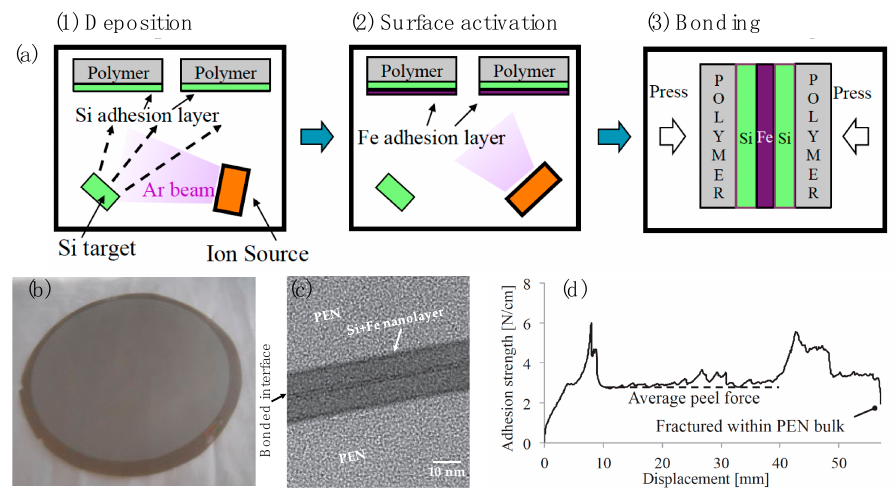
Figure 5. ( a ) Schematic diagram for surface-activated nanoadhesion layers-based bonding of thin polymers; ( b ) Optical image of the void-free interface of 100 mm in diameter PEN/PEN films; ( c ) High-resolution transmission electron microscope image of the bonded interface of PEN/PEN, showing a 20-nm-thick adhesion layer containing Si and Fe; and ( d ) Adhesion behavior of the PEN/PEN bonded interface as a function of displacement during the peel test. Bulk fracture in PEN near the bond interface was observed. From [112] (Copyright 2015 The Japan Society of Applied